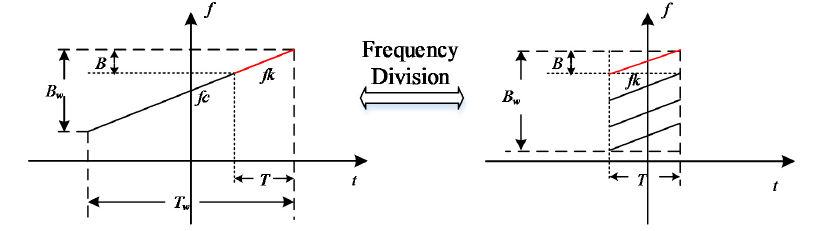
Figure 2. The illustration of the frequency dividing method.